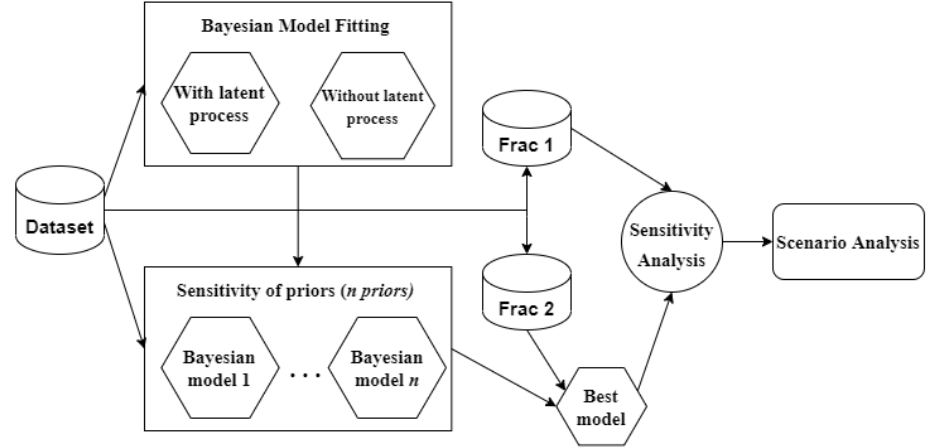
Figure 1. Workflow Diagram. Before investigating the effects of a latent process, the entire dataset is used for Bayesian model fitting. After evaluating the performance of the model for six different priors of the precision parameter, the best model is selected. For sensitivity analysis and scenario analysis in wildfire management, we use a combination of true observations and the best model’s predicted